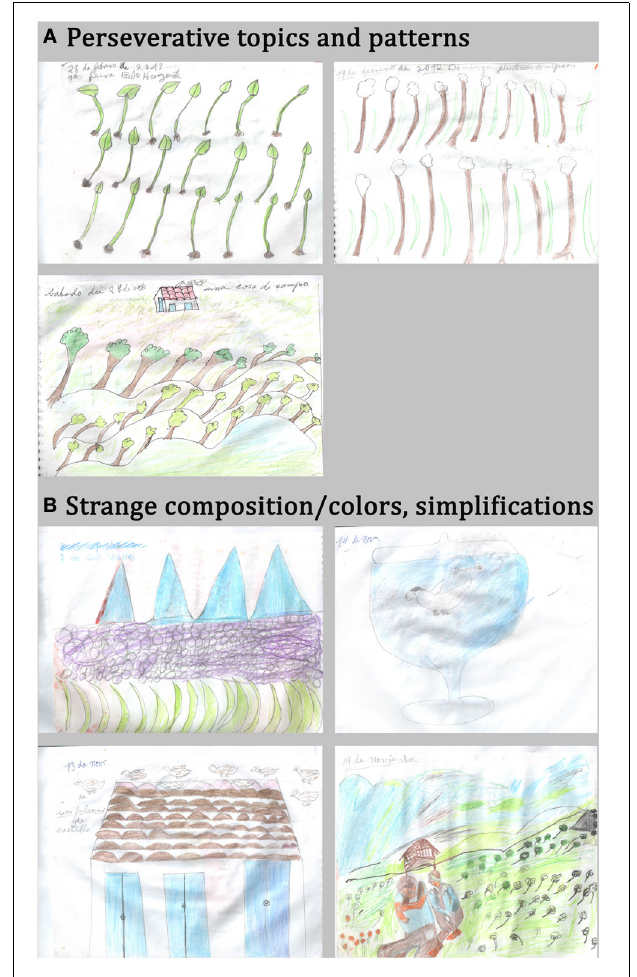
FIGURE 4 | Possible frontal manifestations expressed in the patient’s drawings. (A) Perseverative topics and patterns. (B) Strange composition, color choices and